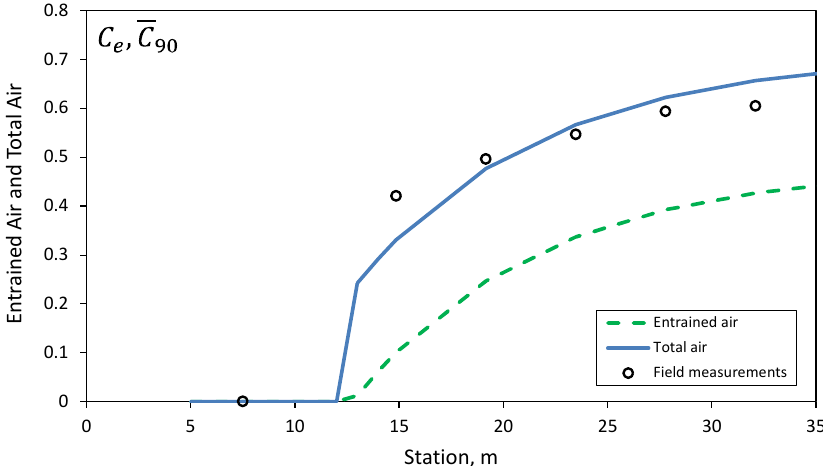
Figure 8. SpillwayPro air concentration predictions vs. Aviemore Dam field data [42].